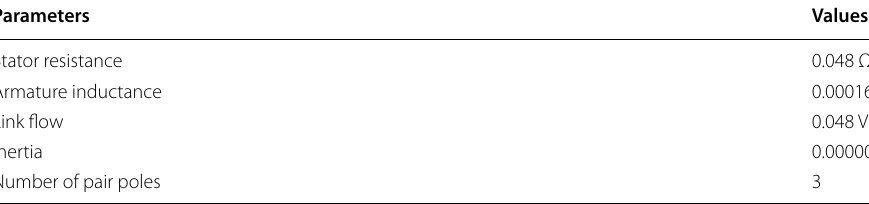
Table 4 Characteristic of wind turbine